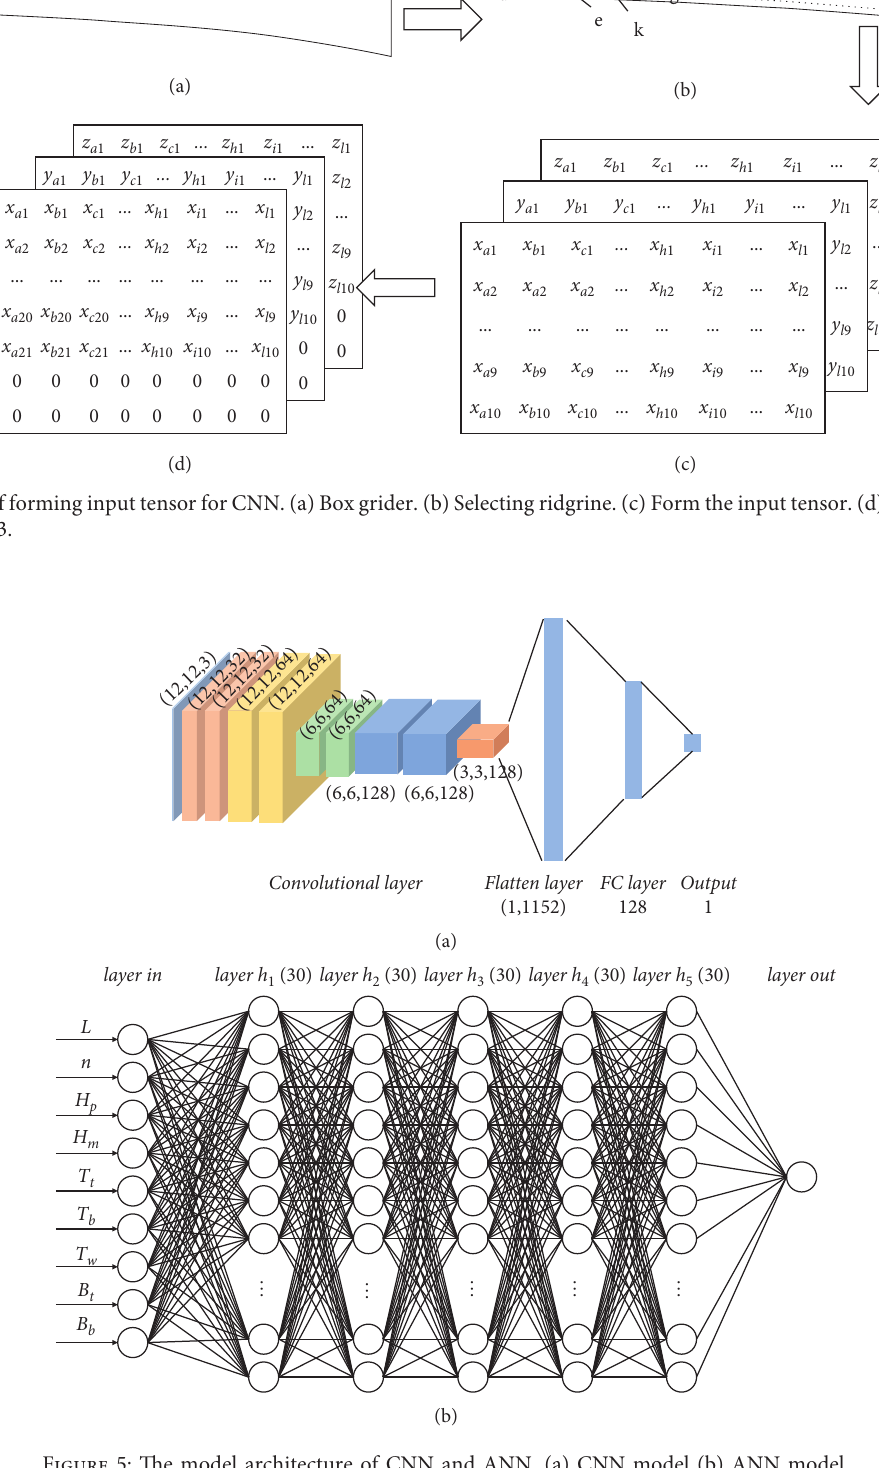
Figure 5: The model architecture of CNN and ANN. (a) CNN model (b) ANN